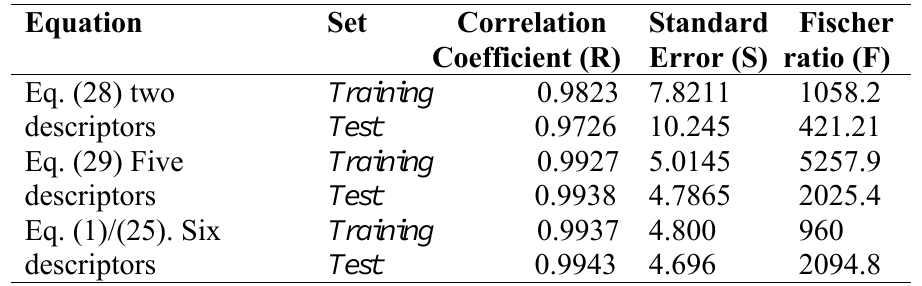
Table 11. Statistical Parameters Corresponding to the Regression Equations for 80 Compounds Present in the Training Data